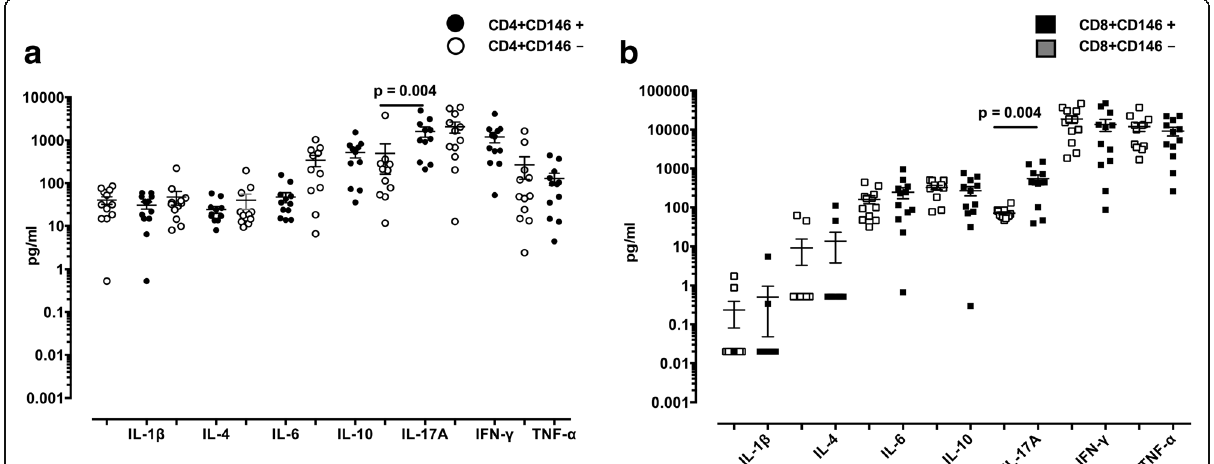
Fig. 4 CD146 + CD4+ and CD8+CD146+ cells secrete significant amount of IL-17A. Lymphocytes from whole blood lysis of healthy human peripheral blood were stained with mouse anti Human mAb CD4, CD8, CD45 RO and CD146 and sorted. Sorted cells were finally washed with IMDM media and plated in 96 well flat bottom culture plate coated with purified antihuman CD3 and CD28 antibodies. Cells were incubated for 5 days and culture supernatant collected to perform multiplex using Luminex. Among analysis performed for various cytokines. Only IL-17 A was found to be significantly high among ( a ) CD146 + CD4+ and ( b ) CD146 + CD8+ cells. Samples were analyzes using Mann Whitney test and p < 0.05 was considered